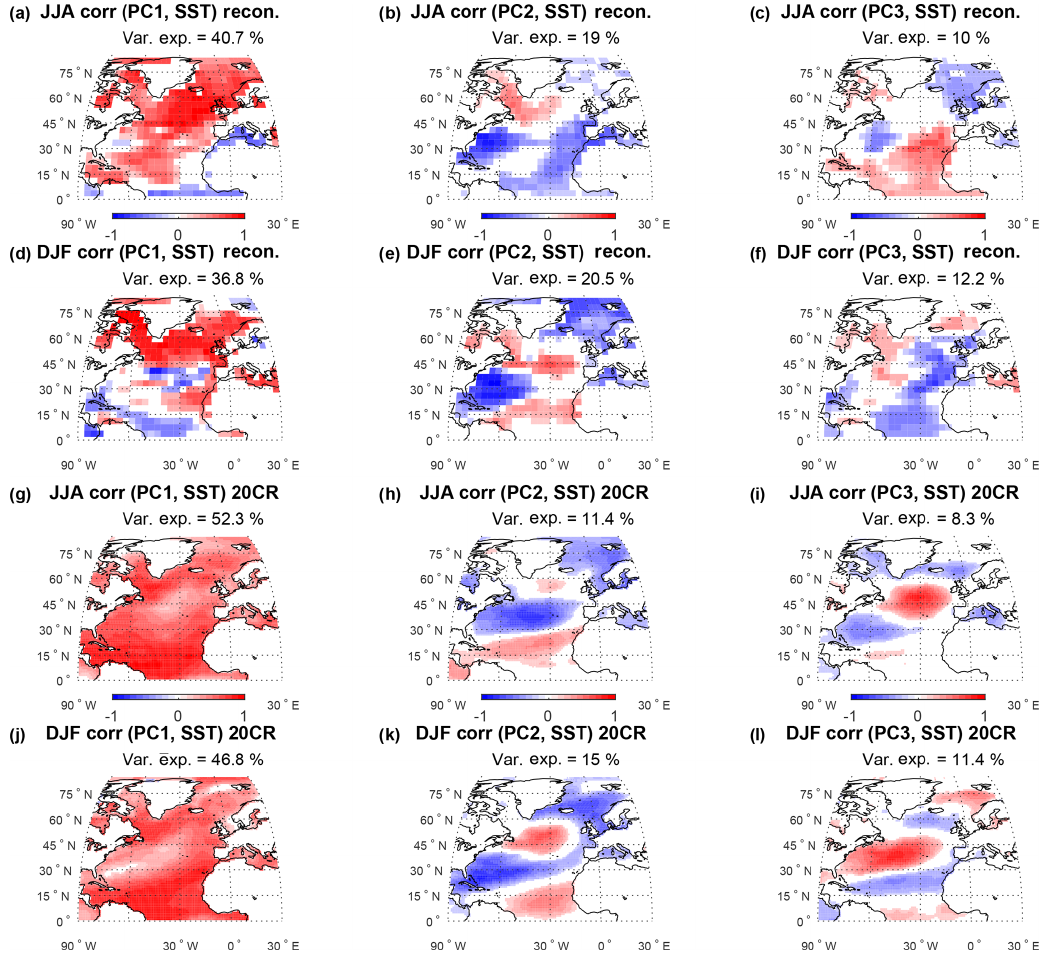
Figure 11. (a–c) Regression of the first three reconstructed PCs of SSTs on reconstructed sum50 JJA SSTs, which corresponds to the reconstructed EOF patterns. Panels (d) – (f) are the same as (a) – (c) but for DJF. Corresponding plots for reconstructions of sum50 (May– October), win50 (November–April) and the winter-centered annual mean (win100, August–July) are shown in Fig. S14. (g–i) Regression of the first three COBE SST PCs on COBE JJA SSTs, which corresponds to the reconstructed EOF patterns. Panels (j) – (l) are the same as (g) – (i) but for DJF. A corresponding figure for 20CR sum50 (May–October), win50 (November–April) and the winter-centered annual mean win100 (August–July) can be found in the Fig. S15. The time period for all plots is 1851–1970. Data only shown for p < 0 .